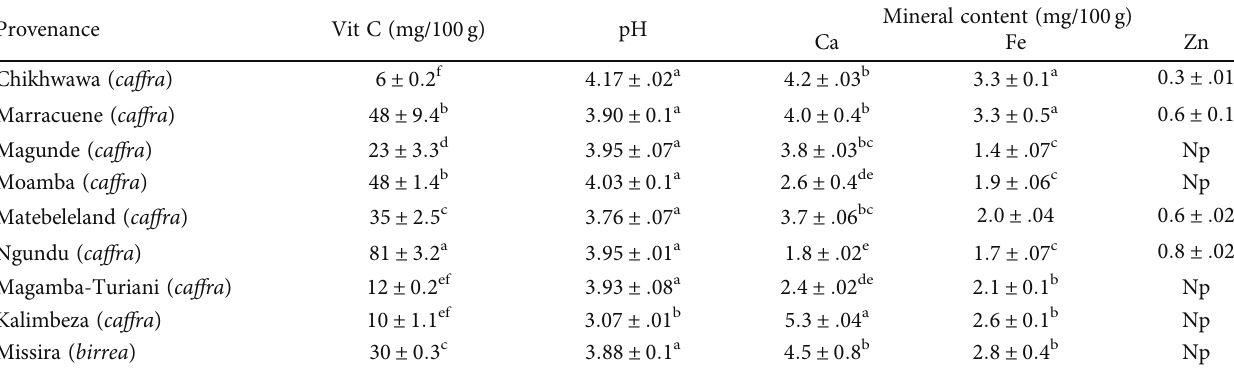
Table 3: Nutritional composition (vitamin C, pH, Ca, Fe, and Zn) of S. birrea fruit pulp among nine provenances. Provenance